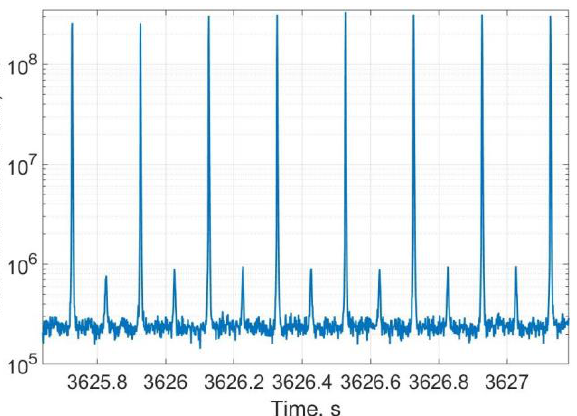
Fig. 8. Normalized count rate of the MSV chain at a constant power of the plant of 450 kW over a short time